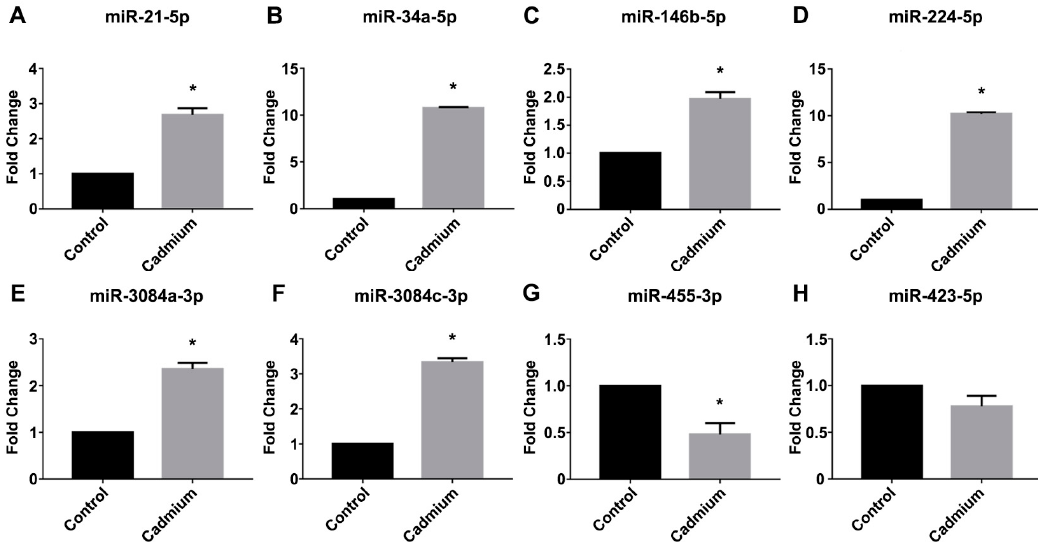
Figure 3. Real-time PCR validation of Cd-dysregulated miRNAs. TaqMan ® Advanced miRNA assays were used to validate selected Cd-dysregulated miRNAs. ( A ) miR-21-5p; ( B ) miR-34a-5p; ( C ) miR-146b-5p; ( D ) miR-224-5p; ( E ) miR-3084a-3p; ( F ) miR-3084c-3p; ( G ) miR-455-3p; ( H ) miR-423-5p. The comparative CT method was used to determine the fold change (±SEM), and an asterisk (*) indicates a statistically significant change in expression in the Cd-treated group versus the saline control ( N = 6 per group, unpaired t -test, p ≤ 0.05).